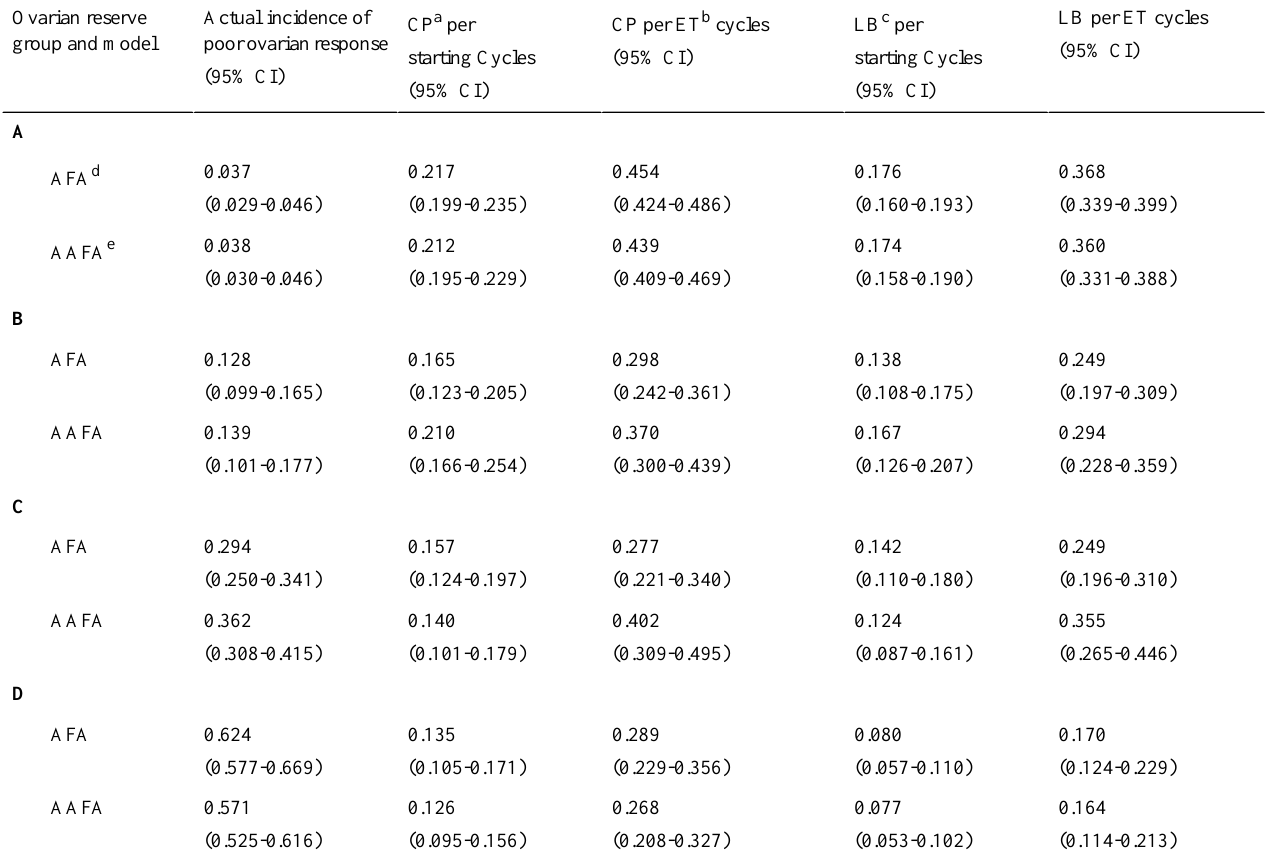
Table 5. The clinical pregnancy rate and live-birth rate in the 4 ovarian reserve